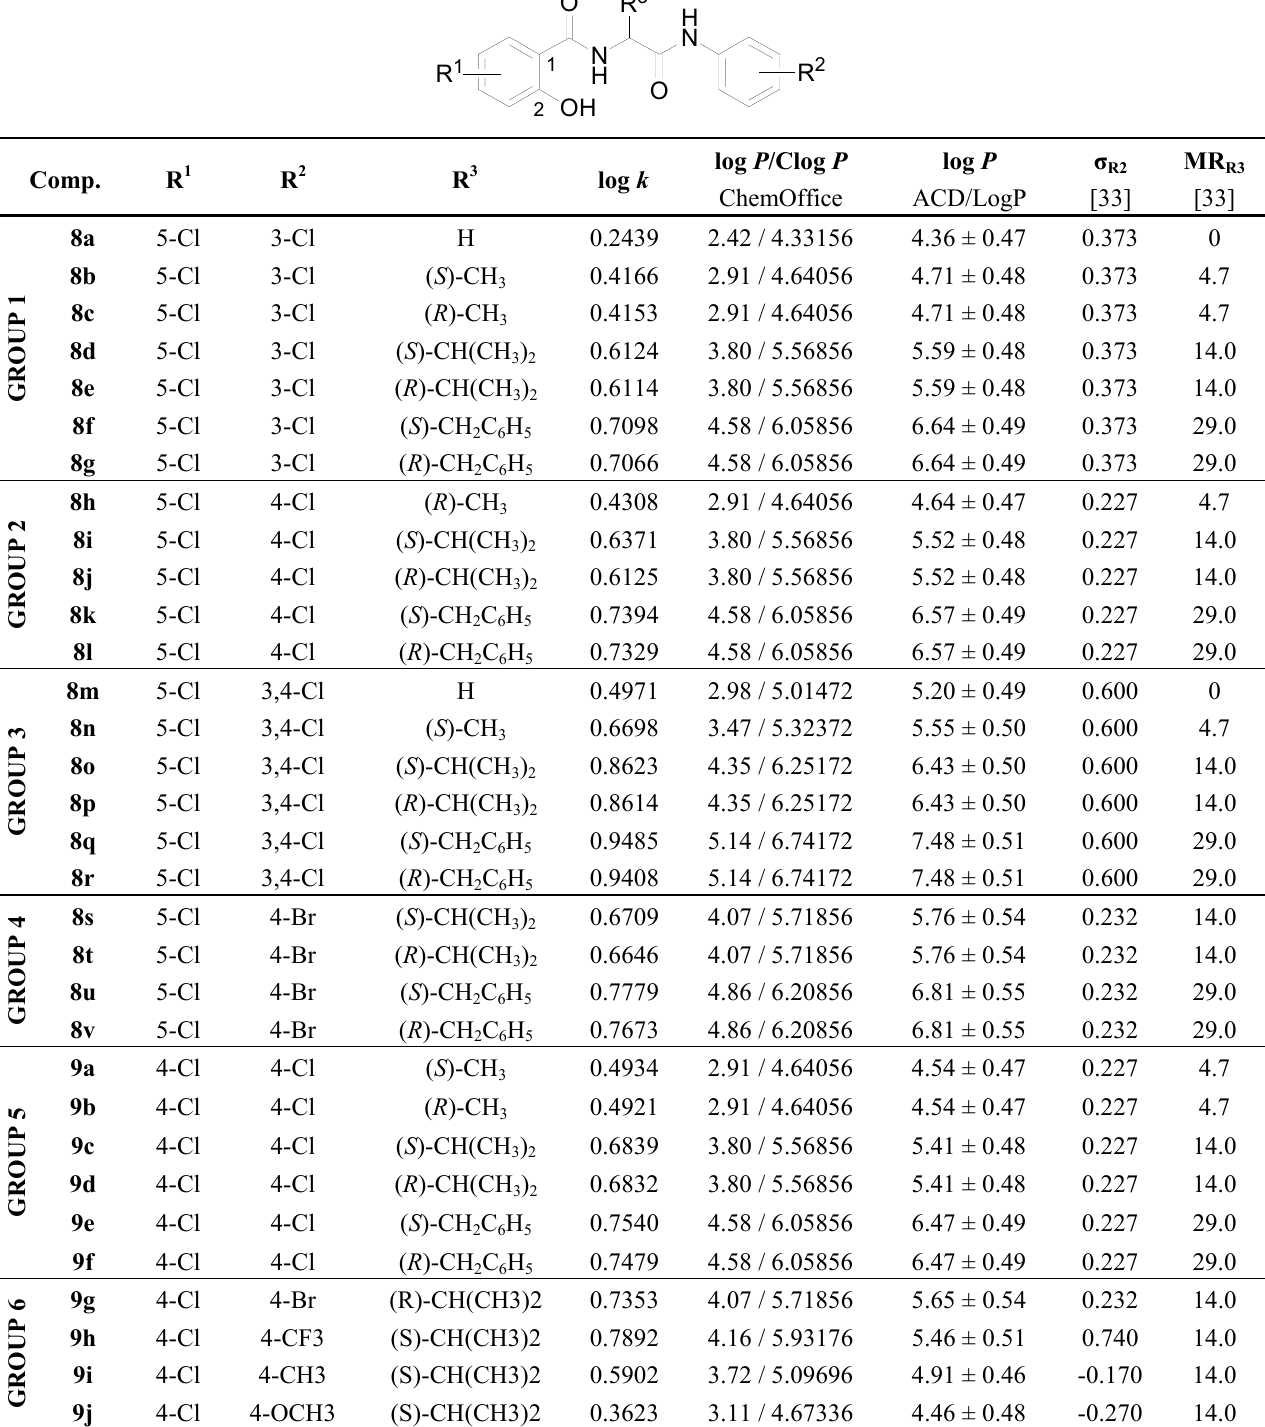
Table 1. Comparison of calculated lipophilicities (log P /Clog P ) with determined log k values, Hammett's parameter ( σ ) and bulk parameter (MR, reflecting bulkiness).